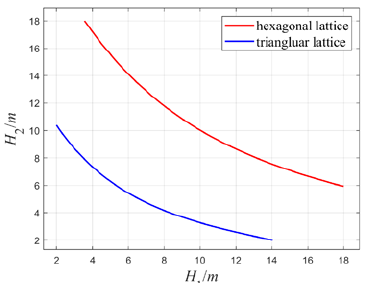
( b ) a triangular hourglass lattice.